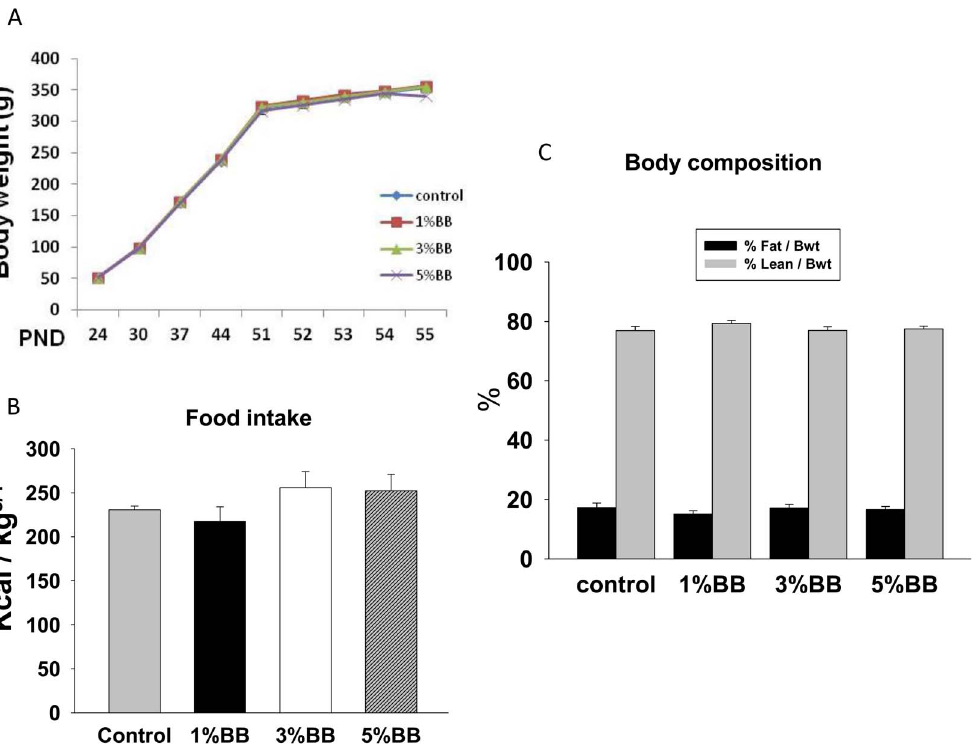
Figure 1. Body weight gain and composition in BB diet rats. (A) Body weight gains were monitored once a week and then daily during the last week. (B) Average food intake shows no differences among non-BB diet and 1, 3, 5% BB diet animal groups. (C) Rat NMR scan shows similar % of fat mass per body weight and % of lean mass per body weight among non-BB diet and 1, 3, 5% BB diet animal groups. Bars represent means 6 SEM; n=10 animals/group.